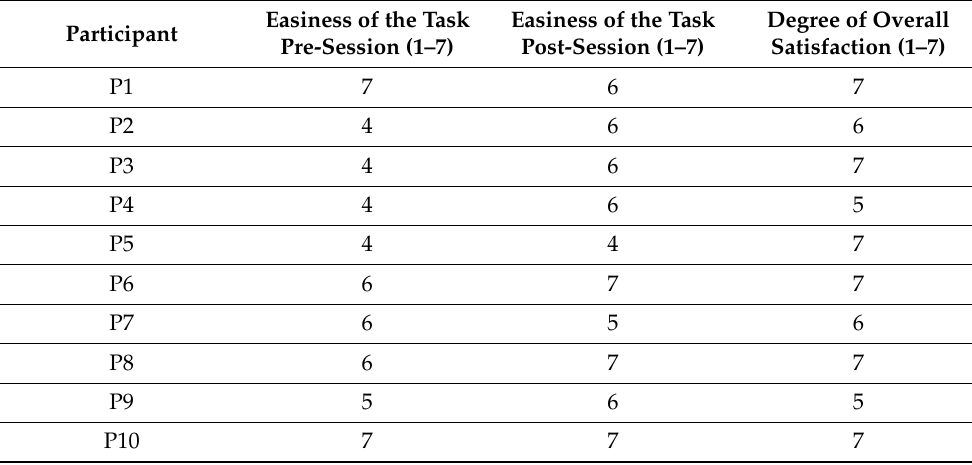
Table 4. Participants’ qualitative self-evaluation of the session/tasks. Easiness of the Task Participant Pre-Session